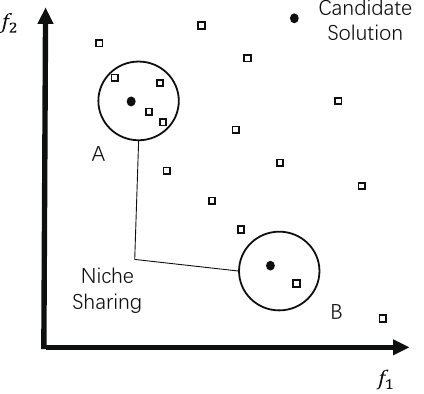
Figure 5. The niche sharing. Neither candidate A nor B is dominant, but A is more aggregated than B , so A has less shared fitness than B and chooses B to participate in the next generation of evolution. This figure is adopted from